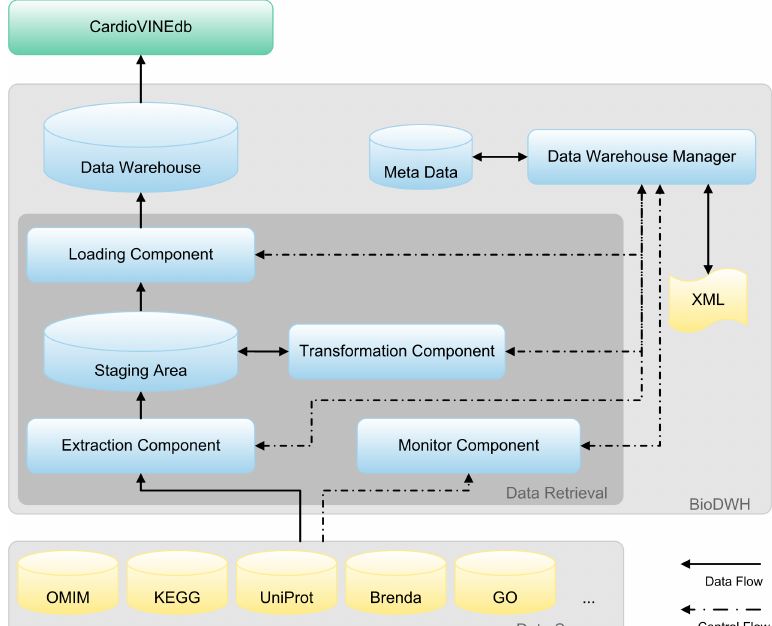
Figure 1: Schematic illustration of the BioDWH system architecture following the general data ware house design. The data source layer comprises parseable flat files, XML files or Structured Query Language (SQL) dumps of the original heterogeneous data sources. BioDWH